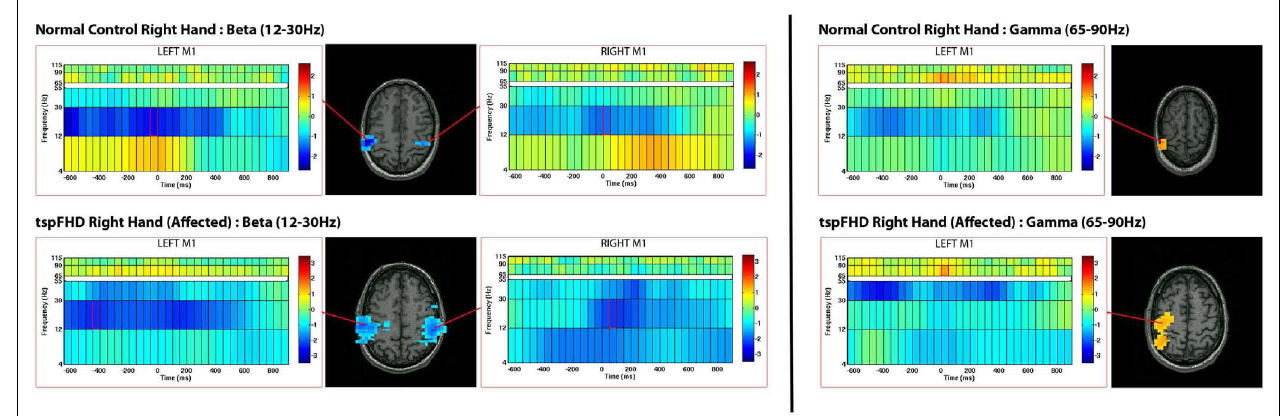
(time = 0ms). Significant decreases (in blue) in beta (12–30Hz) power are identified over bilateral motor cortices in both subjects. Significant increases (in red) in high gamma (65–90Hz) power are identified over similar regions of motor cortex.